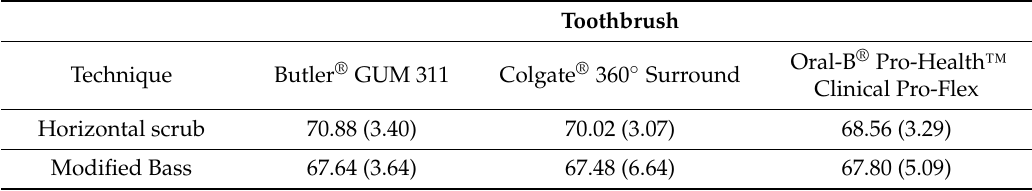
Table 1. Mean whole mouth plaque scores (%) (SD) after brushing.